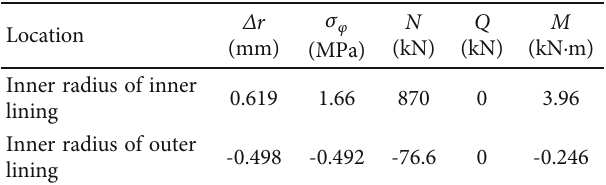
Table 3: Analytical solution